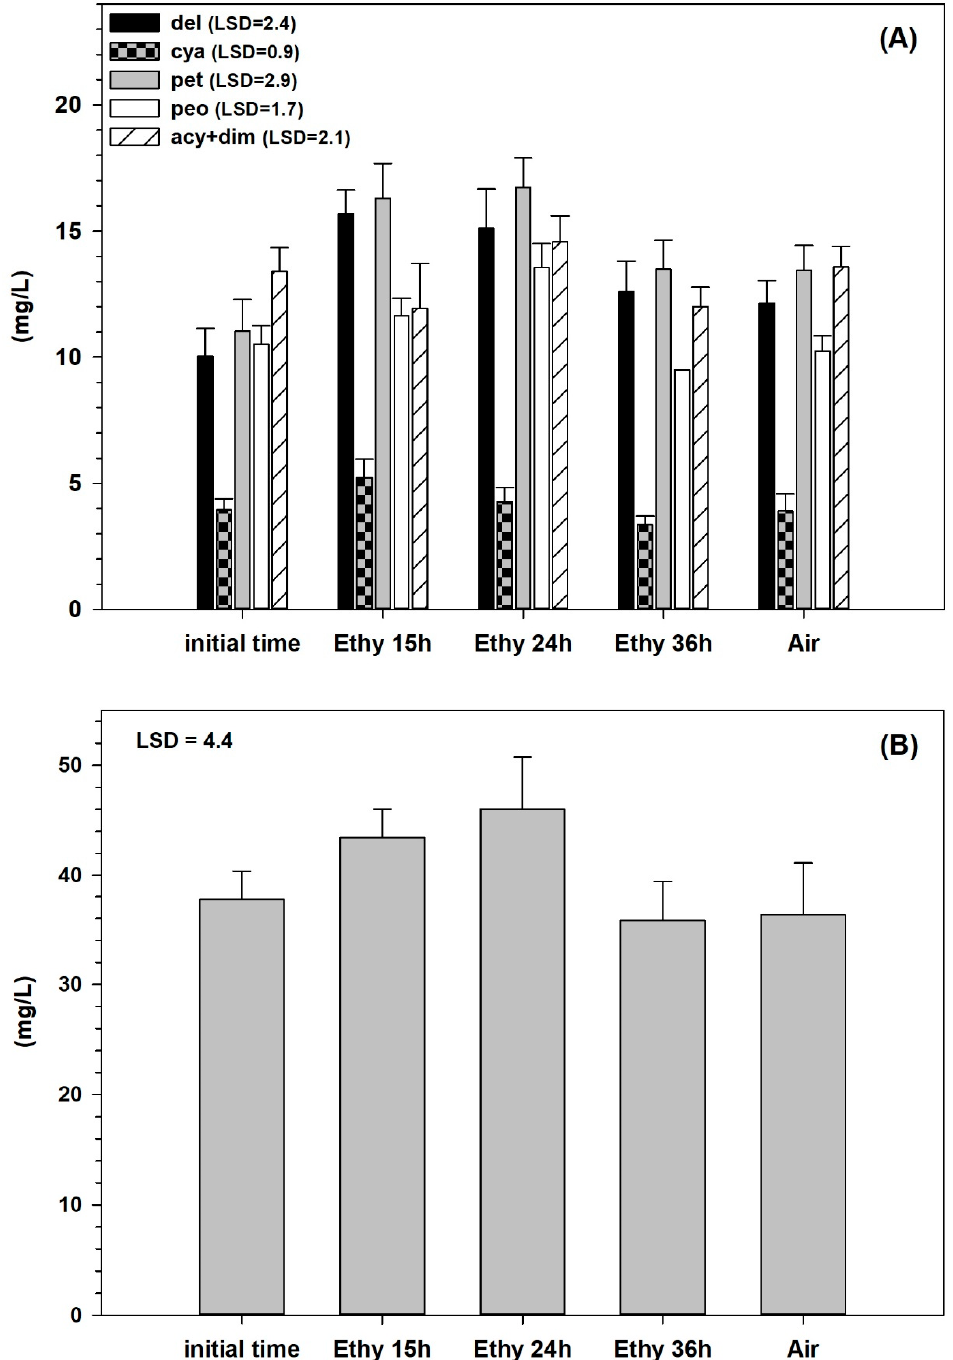
Figure 1. Anthocyanins content (mg L –1 ) in fresh sample and at the end of the experiment (36 h) in Cesanese grapes treated with ethylene for 15, 24, and 36 h or air for 36 h. Values represent means of three analyses from three different bunches ± SD. Calculated LSD (mg L –1 ) is per p = 0.05 ( A ). Malvidin content (mg L − 1 ) in fresh sample and at the end of the experiment (36 h) in Cesanese grapes treated with ethylene for 15, 24, and 36 h or air for 36 h. Values represent means of three analyses from three different bunches ± SD. Calculated LSD (mg L –1 ) is per p = 0.05 ( B ).